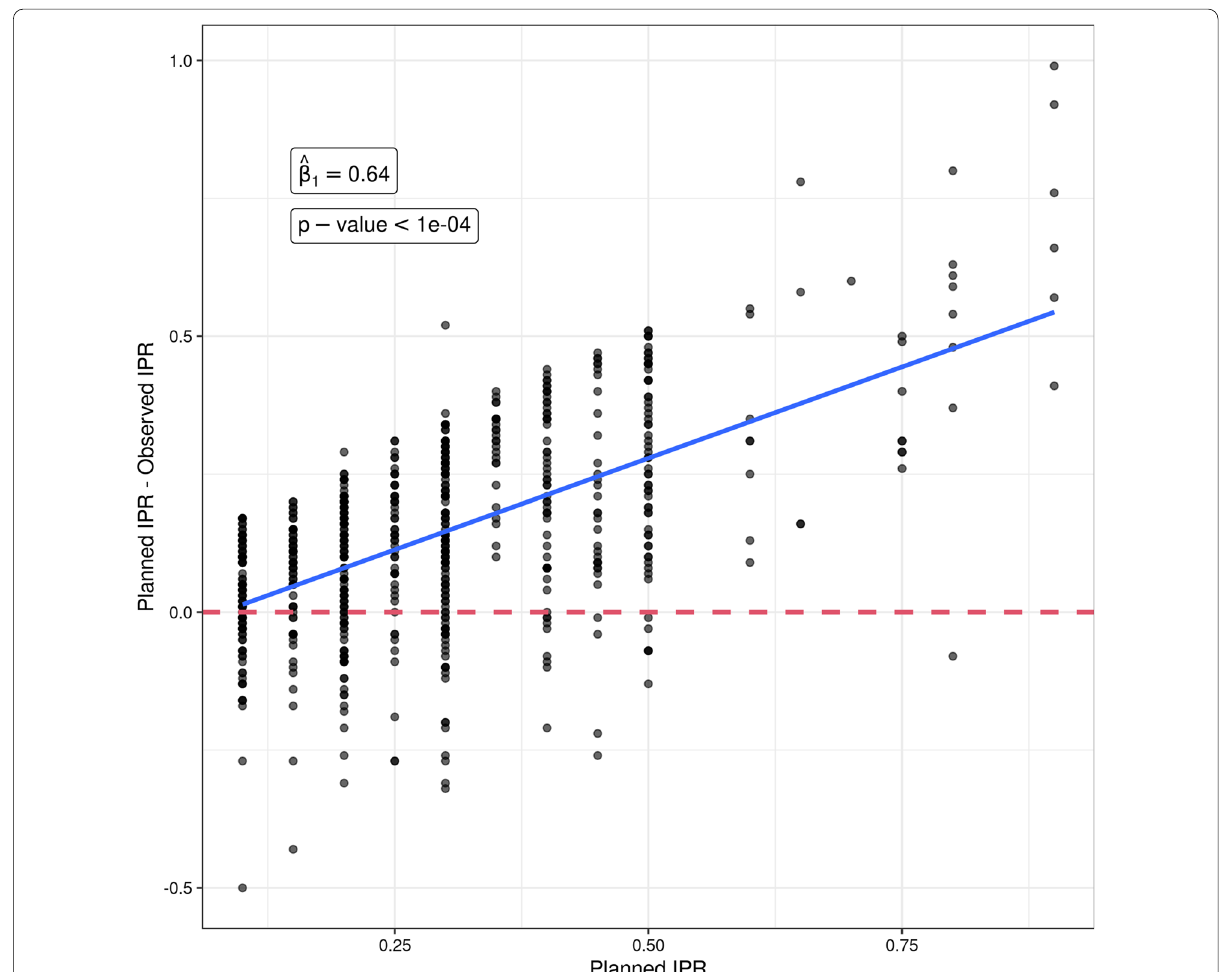
Fig. 3 Association between P‑IPR to the discrepancy between implemented and programmed